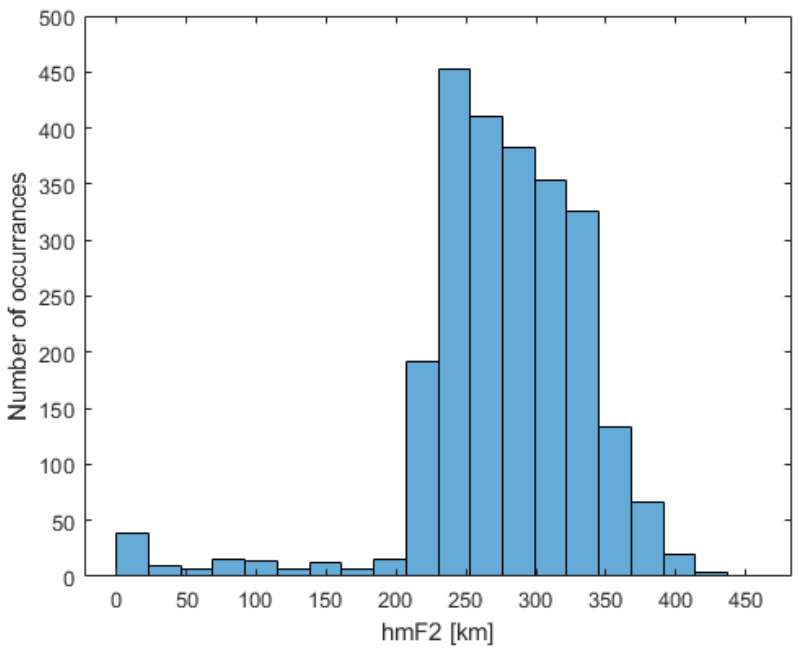
Figure 20. Distribution of the hmF2 extracted from Formosat3 ionospheric profiles.